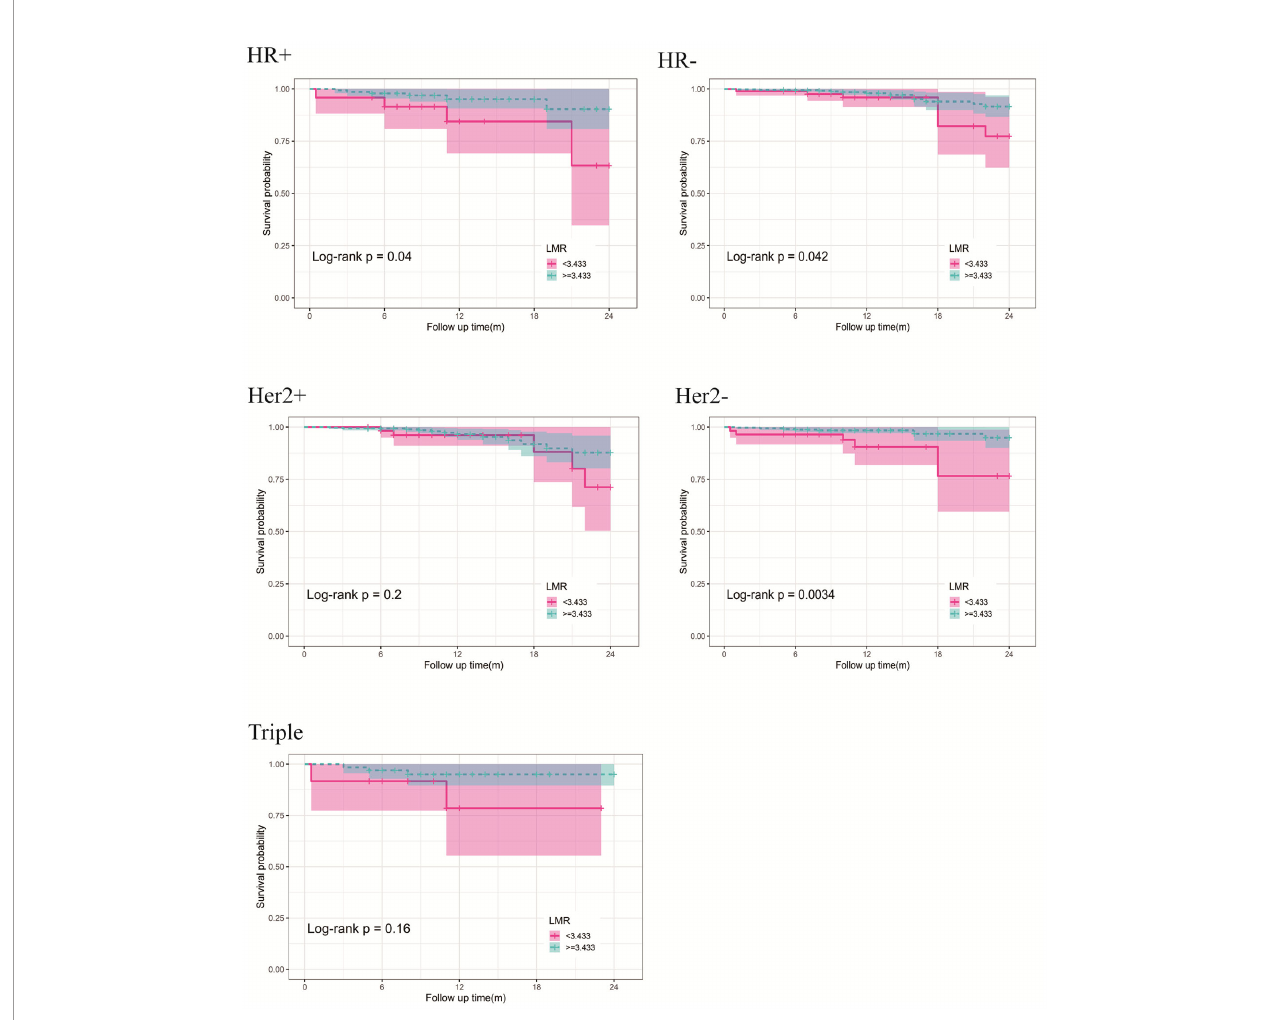
FIGURE 6 | Kaplan-Meier curves of DFS differences strati fi ed by the molecular subtypes between the high- and low-LMR groups in the stage I-III